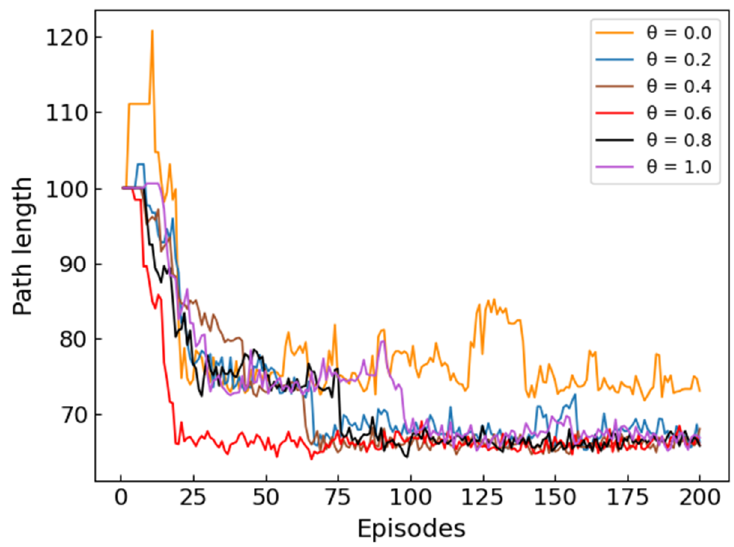
Figure 9. The path length change process of each set of parameters.